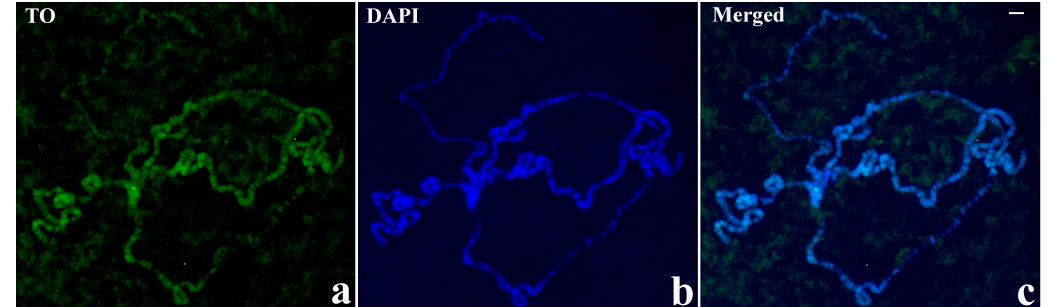
Figure 9. TO and DAPI staining in polytene chromosomes of D. melanogaster wild type. TO staining ( a , TO). The corresponding DAPI staining ( b , DAPI) and the two superimposed images( c , Merged). Scale bar corresponds to 25 m.